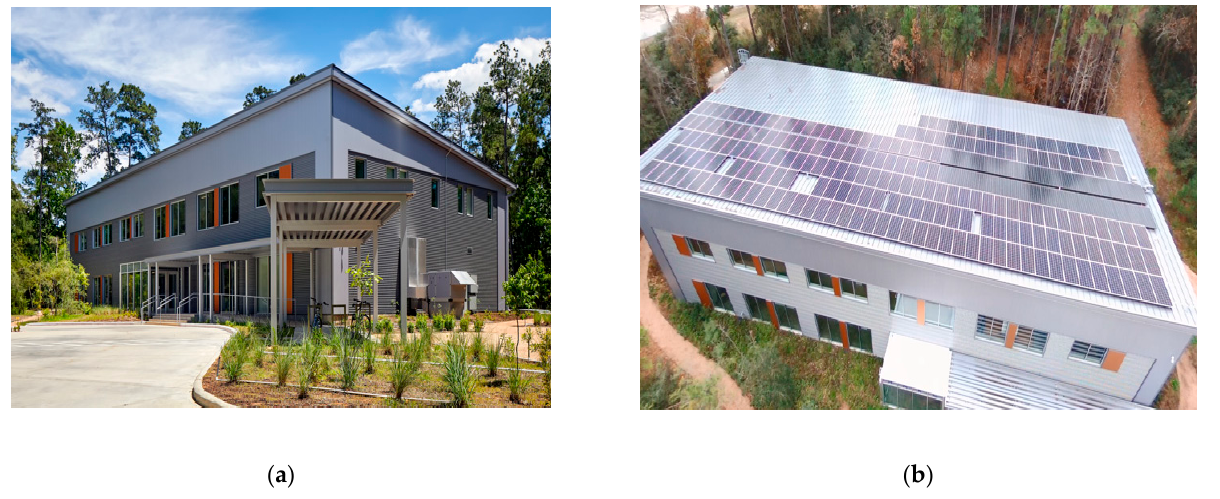
Figure 2. The Houston Advanced Research Center Building: ( a ) outside view, ( b ) photovoltaics arra y .